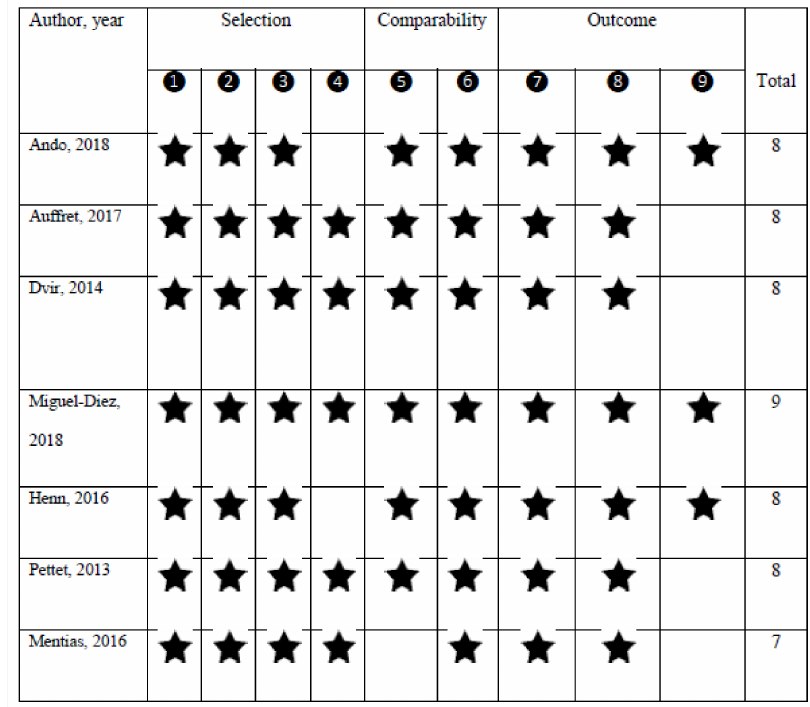
Figure 2. The quality assessment of the studies according to the nine-star Newcastle–Ottawa Scale (NOS) scoring system.